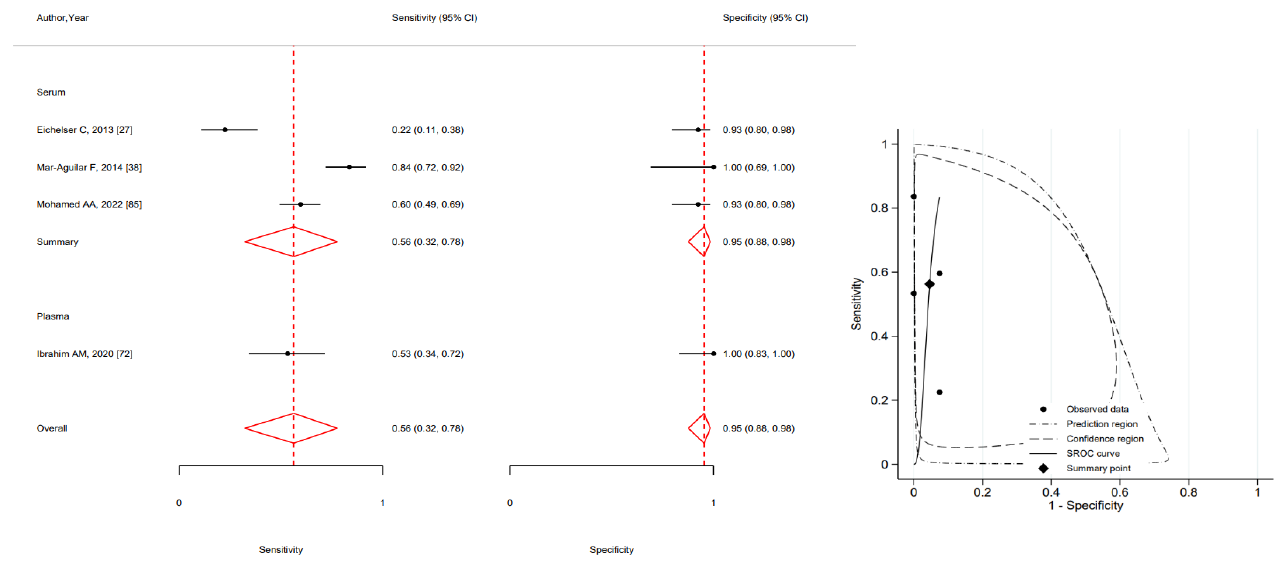
Figure 5. Forest plot of included studies assessing the sensitivity and specificity by type of specimen and summary receiver operating characteristic curve (SROC) of MIR10b in breast cancer diagnosis (squares shows sensitivity and specificity, respectively; red diamonds show pooled effect; error bars represents 95% confidence interval) [27,38,72,85].